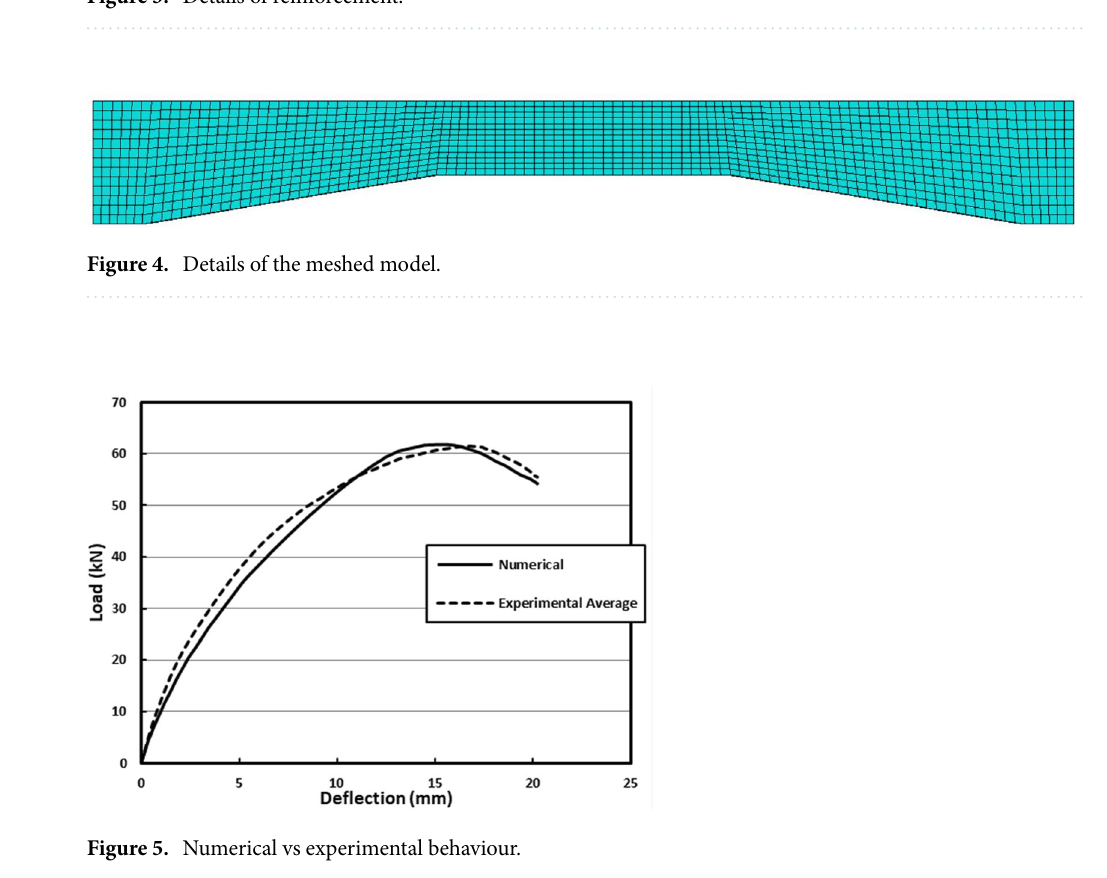
Figure 3. Details of reinforcement.